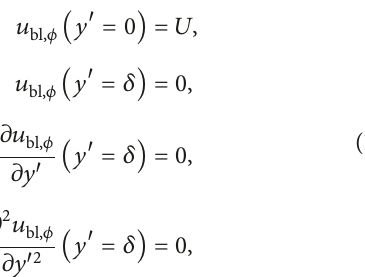
ing flow cross-sections in circumferential direction opening boundary conditions are defined which are noticeable by blue arrows in Figure 5(b).